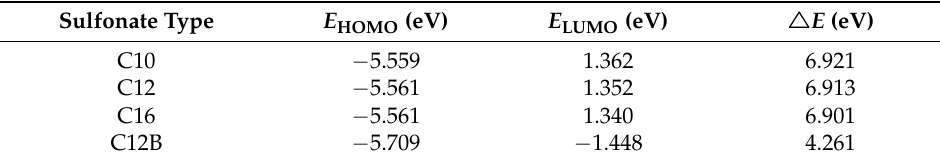
Table 2. Frontier orbital energies of sulfonate-based